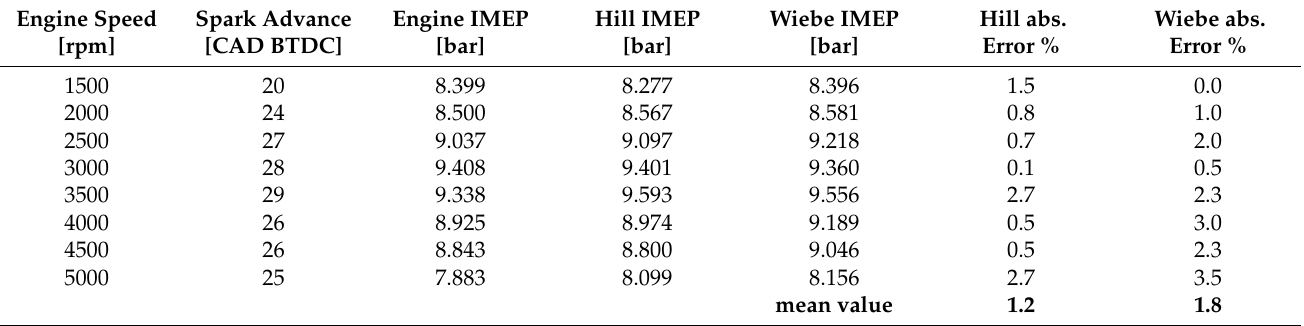
Figure 3. Comparison between the experimental and simulated IMEP; 40% NG fuel mixture. ( a ) MAP = 1.4 bar; ( b ) MAP = 1.6 bar. Table 4. Experimental and simulated IMEP with absolute prediction errors (40% NG; MAP = 1 bar).